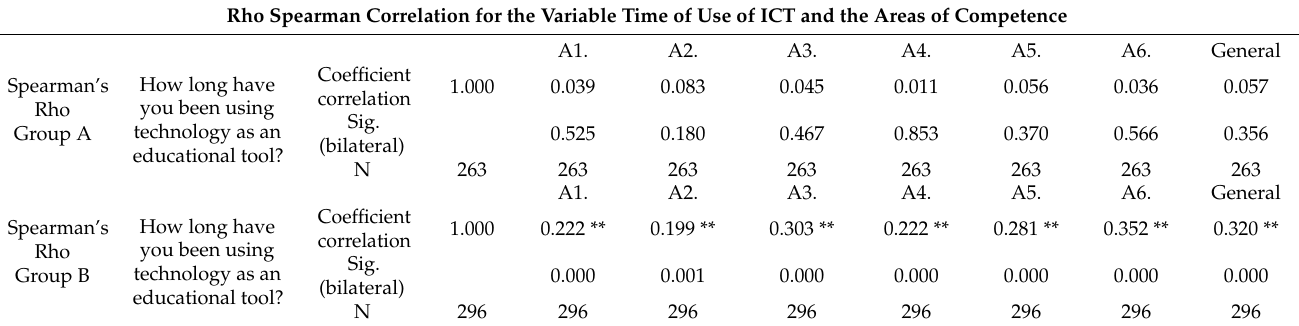
Table 8. Rho Spearman correlation for the variable time of use of ICT and the areas of competence in group A and group B. Rho Spearman Correlation for the Variable Time of Use of ICT and the Areas of